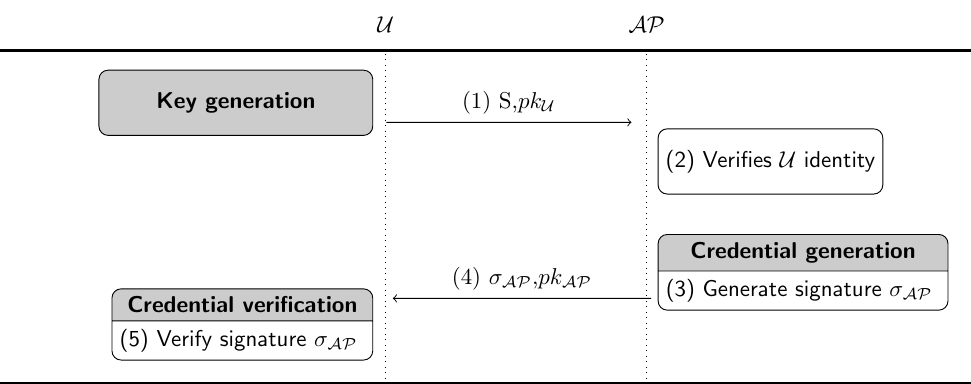
Figure 2. Message exchange between